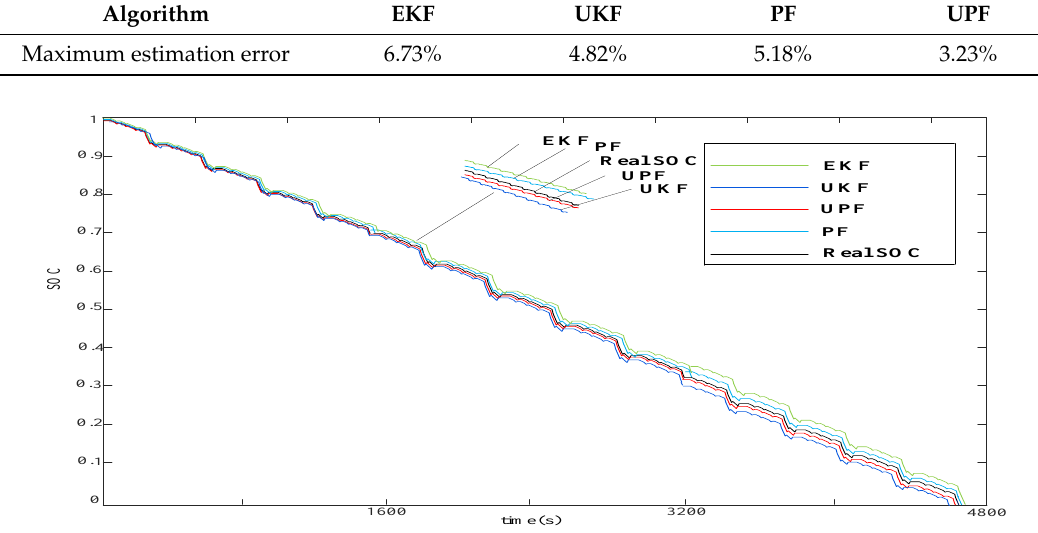
Figure 20. Estimation error curves of different methods. Table 10. Maximum Estimation Error of Different Methods at 25 °C. Table 11. Maximum Estimation Error of Di ff erent Methods at − 10 ◦ C.